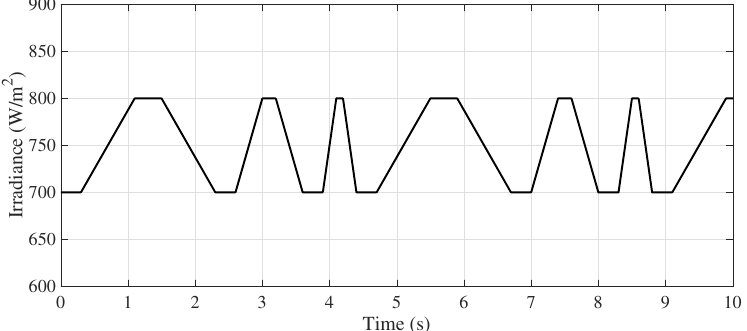
Figure 10. Irradiation profile based on EN50530 standard.